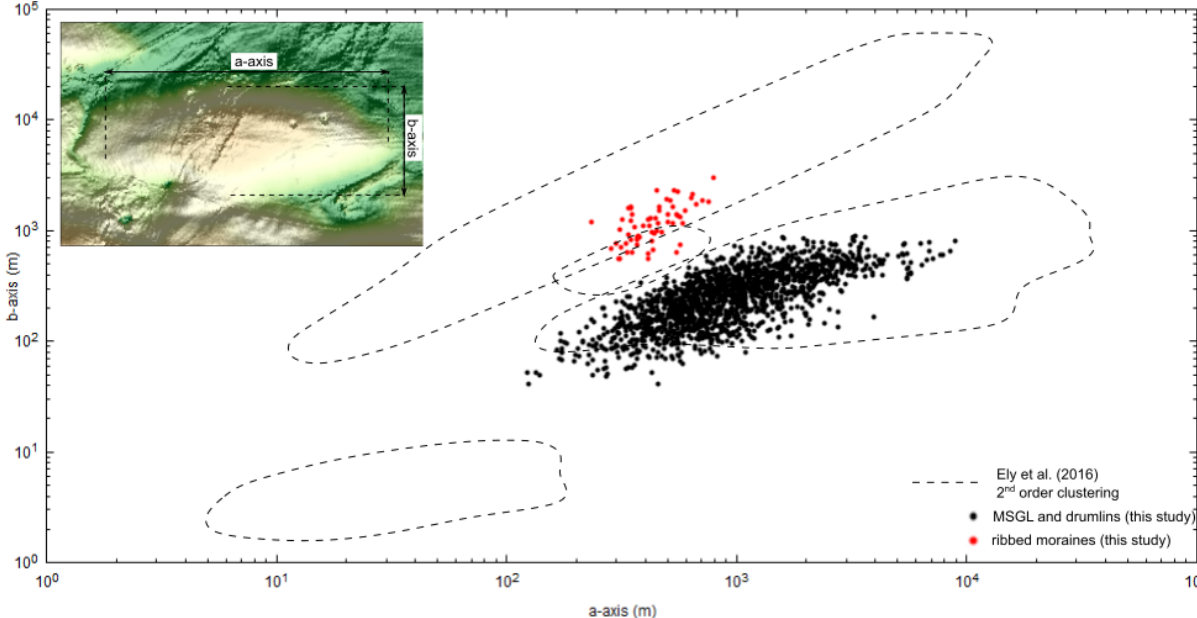
Figure 4. Dimensions of mapped MSGLs, drumlins, and ribbed moraines on top of a subglacial bedform continuum presented by Ely et al. (2016) as ellipsoidal geomorphological